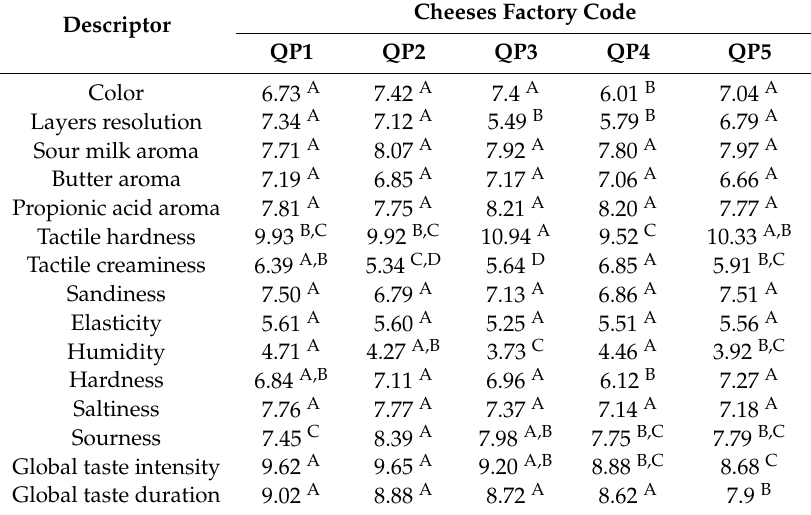
Table 4. Intensity scores for the sensory attributes identified of Poro cheese.